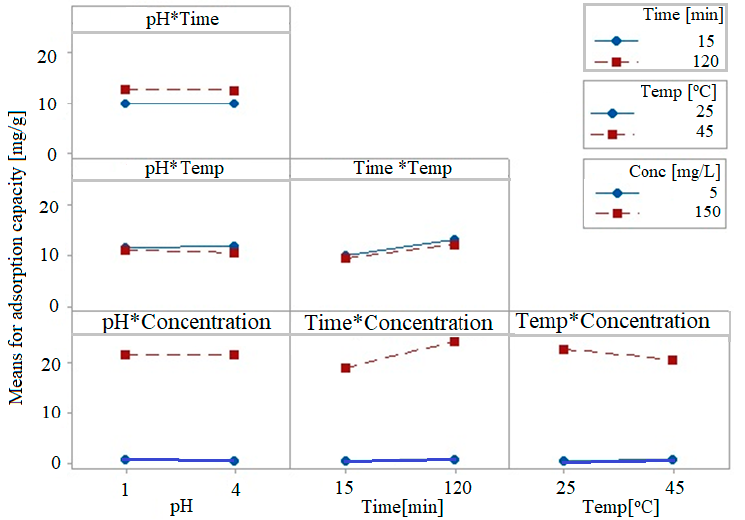
Figure 7. Interactions between the control factors and the response of the adsorption process (adsorption capacity).